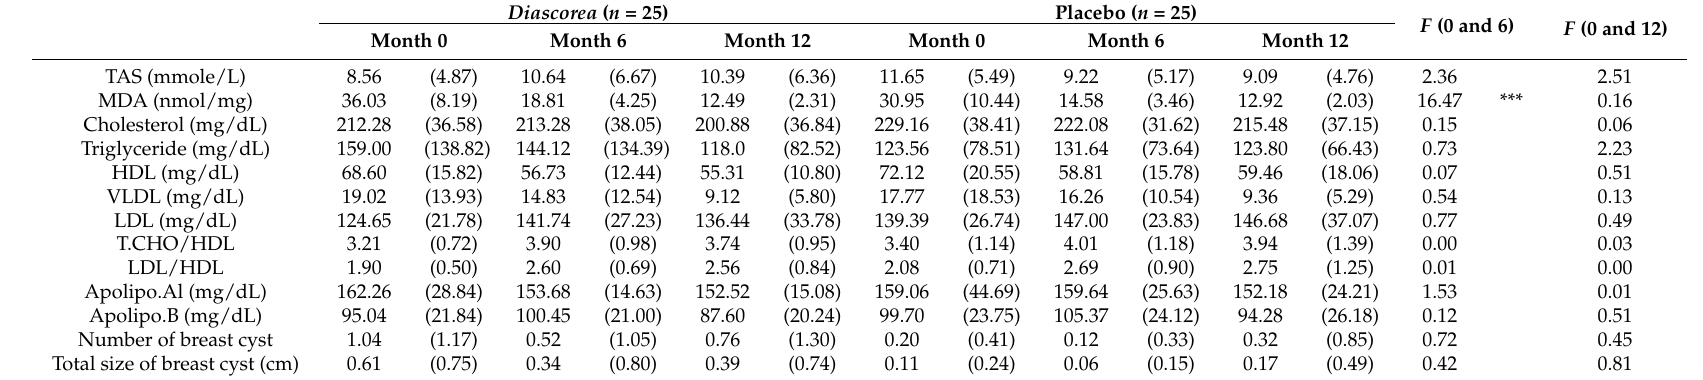
Table 2. The effects of Diascorea on antioxidant status, lipid profiles, and breast cysts after six and 12 months. Data are given as the mean (standard